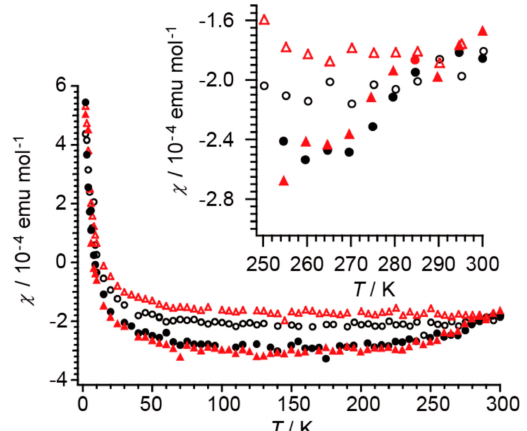
Figure 16. Temperature-dependence of magnetic susceptibility. Circles (black) and triangles (red) are data obtained in the dark and under UV irradiation, respectively. Open and closed symbols correspond to ZFC and FC data, respectively. The data include diamagnetic contributions from the core electrons of BPY[Au(dmit) 2 ] 2 (inset: enlarged view at T C ~280 K). Reproduced from Ref. [13] with permission from the Royal Society of